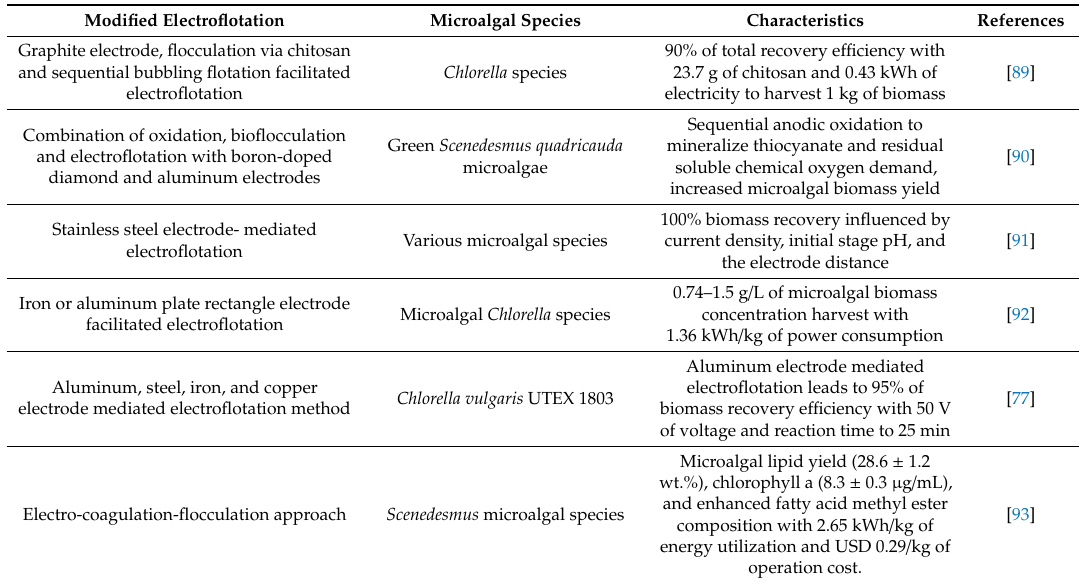
Table 7. Modified electroflotation approach for the e ffi cient recovery of microalgal